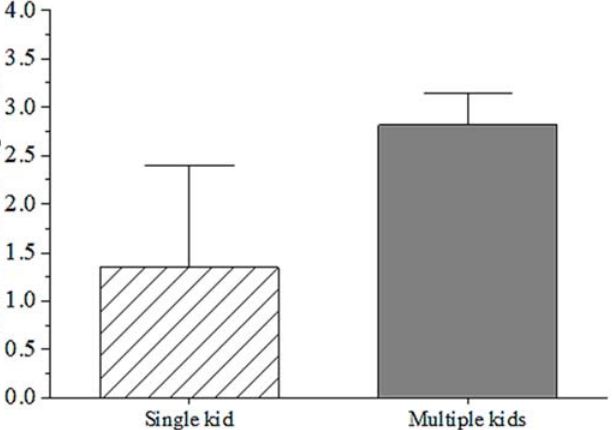
Figure 4. The mRNA expression of goat DNAH1 gene in ovarian tissues of mothers of single kids and mothers of multiple kids.